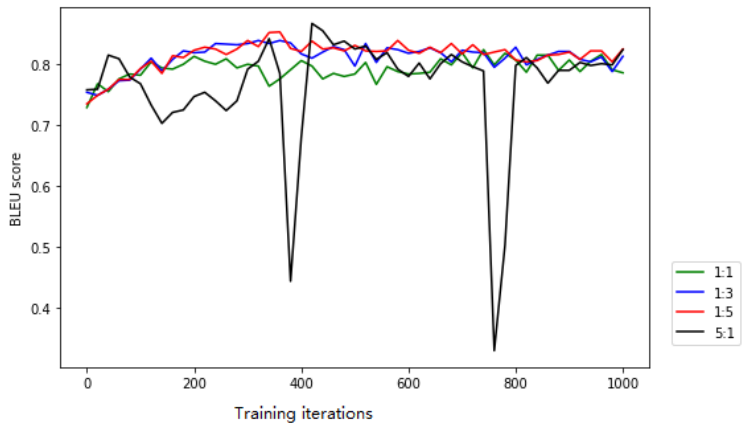
Figure 9. The BLEU-2 scores for the COCO image captions with k = 5, 1, 1/3, and